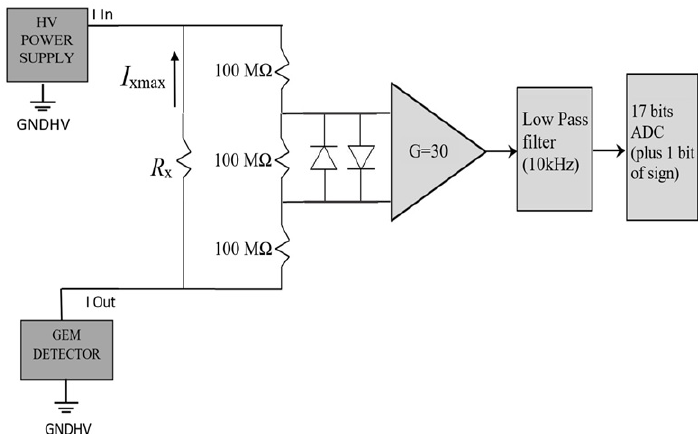
Figure 2. Array of resistors and diodes used to protect ammeters from short